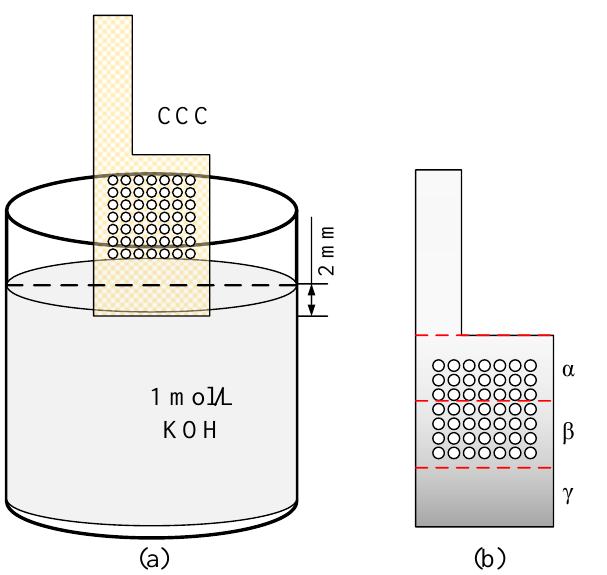
Figure 3. Wettability modification for the CCC. ( a ) The diagram of immersion; ( b ) Gradient